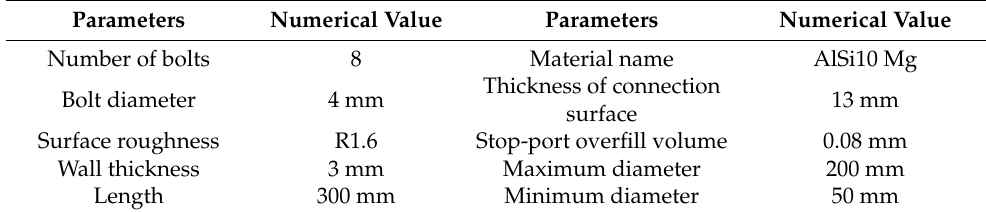
Table 1. Geometric parameters of experimental parts.